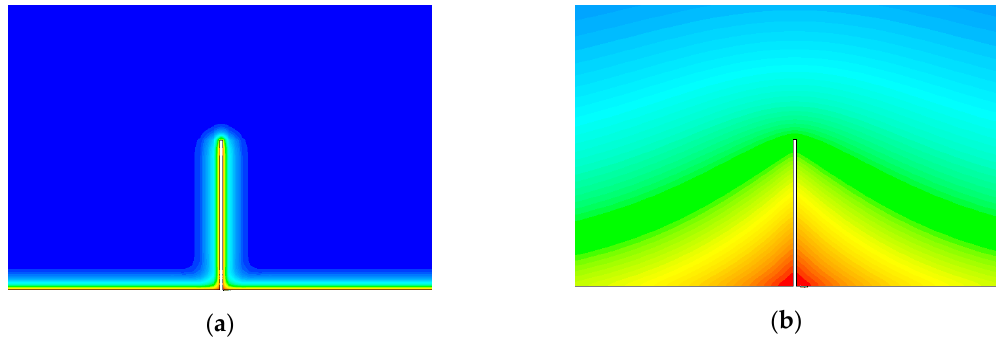
Figure 1. Simulation model (simu.2) results shown close-up to a vertical surface crack with a depth of 1 mm. Material: ferro-magnetic steel, properties are listed in Table 1. Excitation frequency is 200 kHz. ( a ) Joule-heating. ( b ) Temperature distribution after a 0.1 s heating duration.